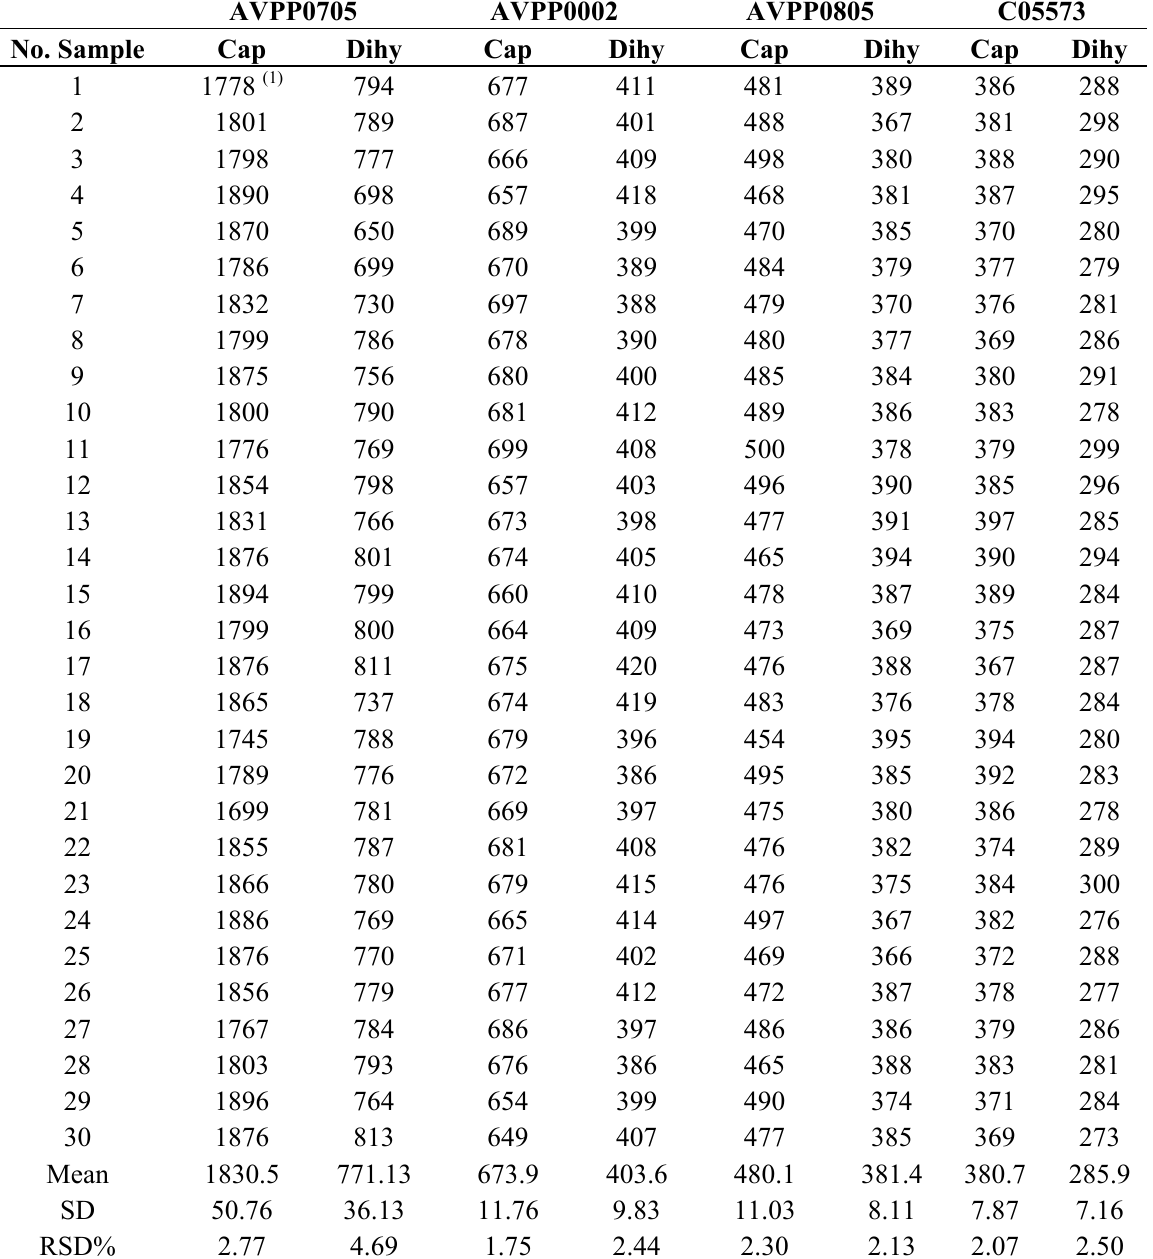
Table 3. Intra-day repeatability data of the UFLC method for the determination of capsaicinoids in pepper ( μ